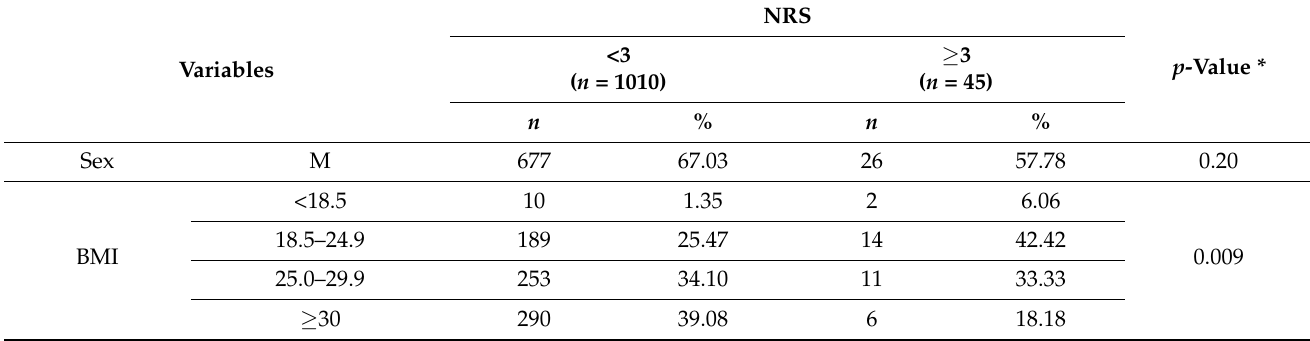
Table 4. The comparison of assessed parameters (qualitative variables) with NRS